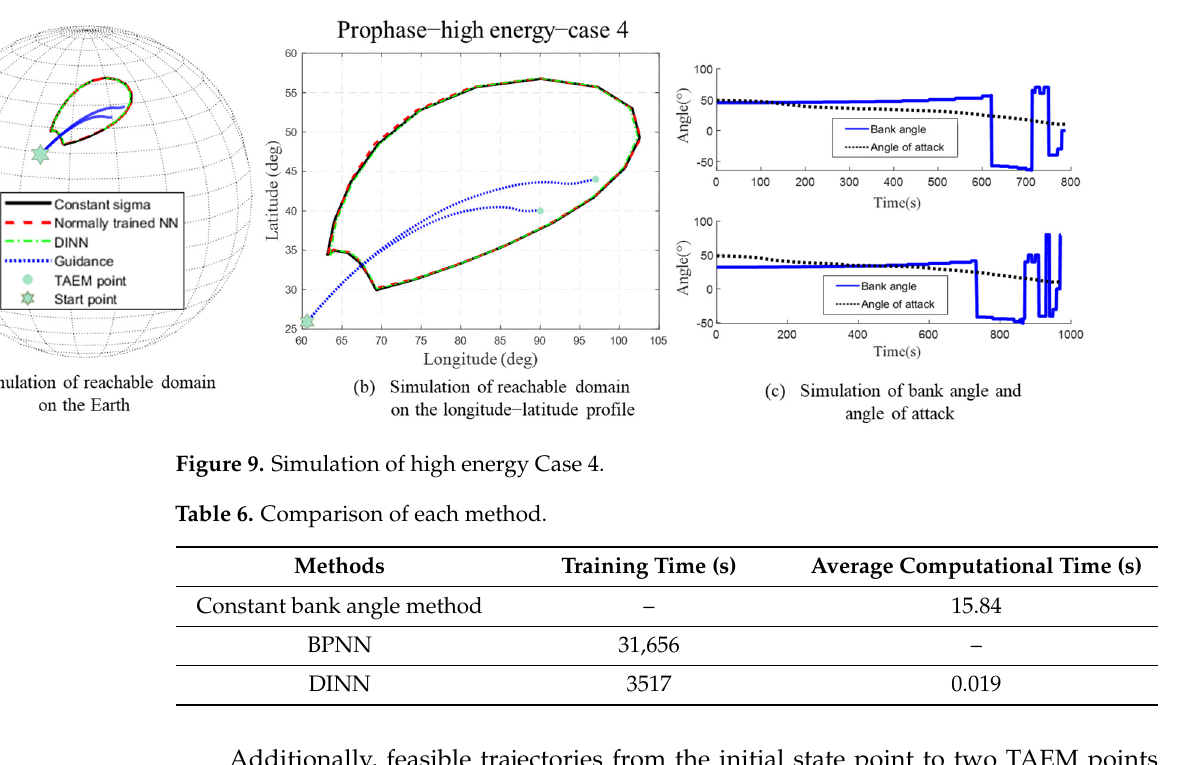
Table 7. The drop point error of high energy cases 1–4.